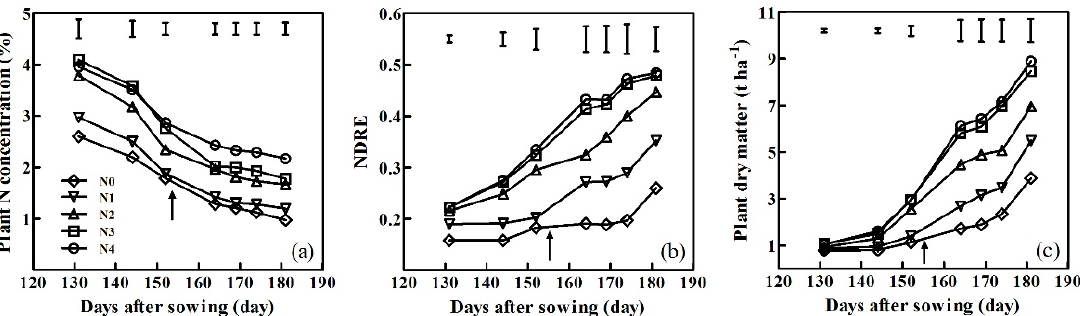
Figure 3. Changes in plant N concentrations ( a ), normalized di ff erence red edge (NDRE) ( b ) and plant dry matter (PDM) ( c ) after sowing under di ff erent N treatments using ‘Xumai30’ in Experiment 2 as an example. Arrows indicate the days of topdressing N application. Vertical bars at each sampling date represent the LSD values ( P ≤ 0.05).